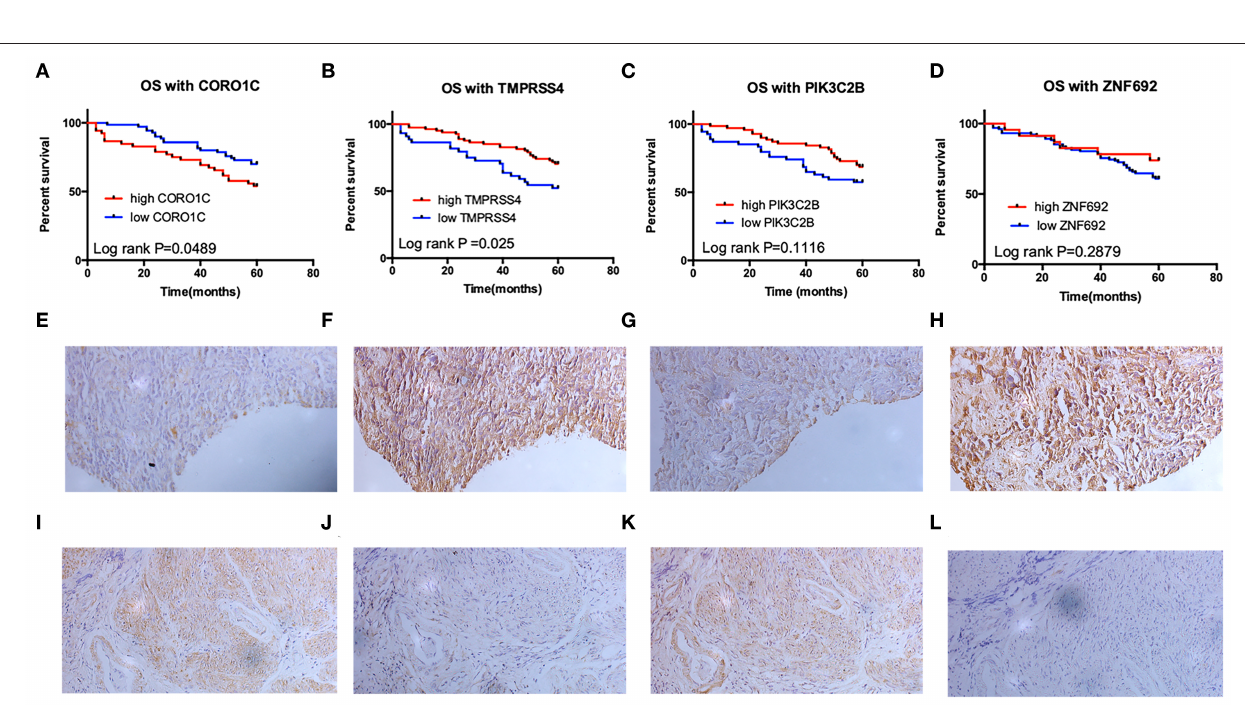
Frontiers in Oncology | www.frontiersin.org